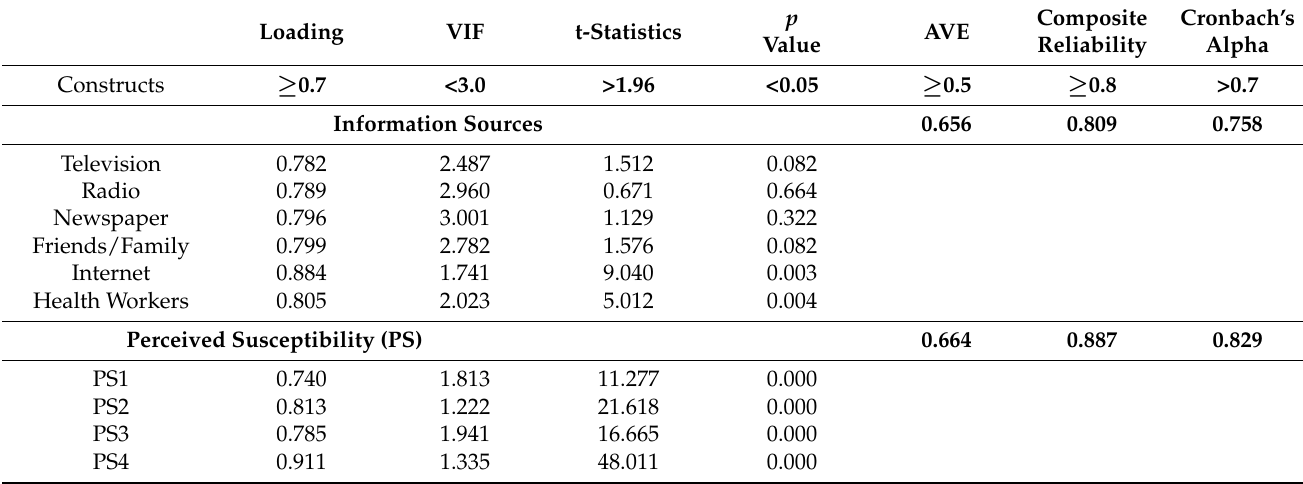
Table 2. Construct validity and reliability for Hypothesis